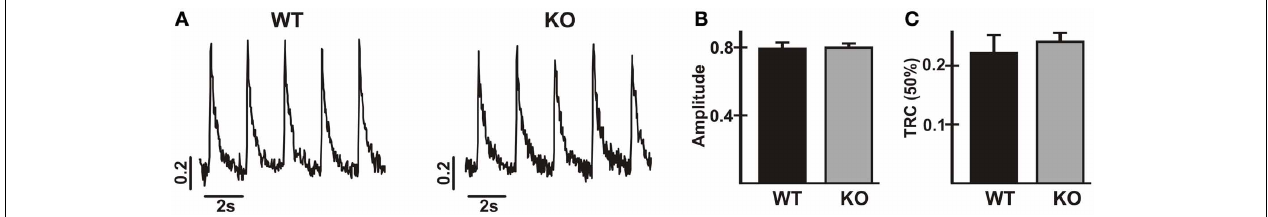
FIGURE 5 | Analysis of Ca 2 + -transients in cardiac myocytes from wild-type and AE3-null mice. Ca 2 + -transients were calculated as 340/380 ratios from fluorescence measurements in isolated myocytes from WT and AE3-null (KO) mice loaded with Fura-2. Results show: (A)